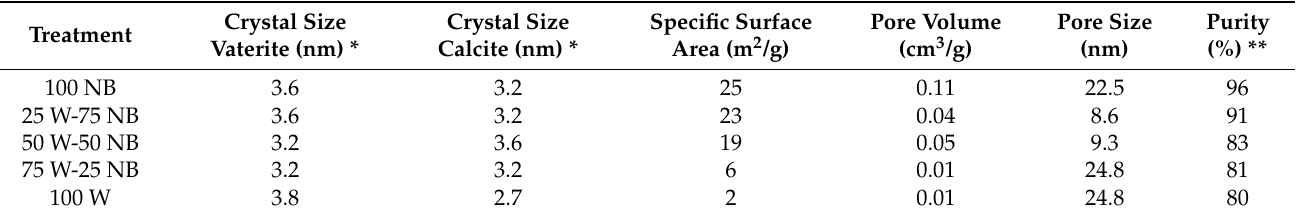
Table 1. Effect of whey concentration in nutrient broth on crystal size and specific surface area, pore size and pore volume of biogenic CaCO